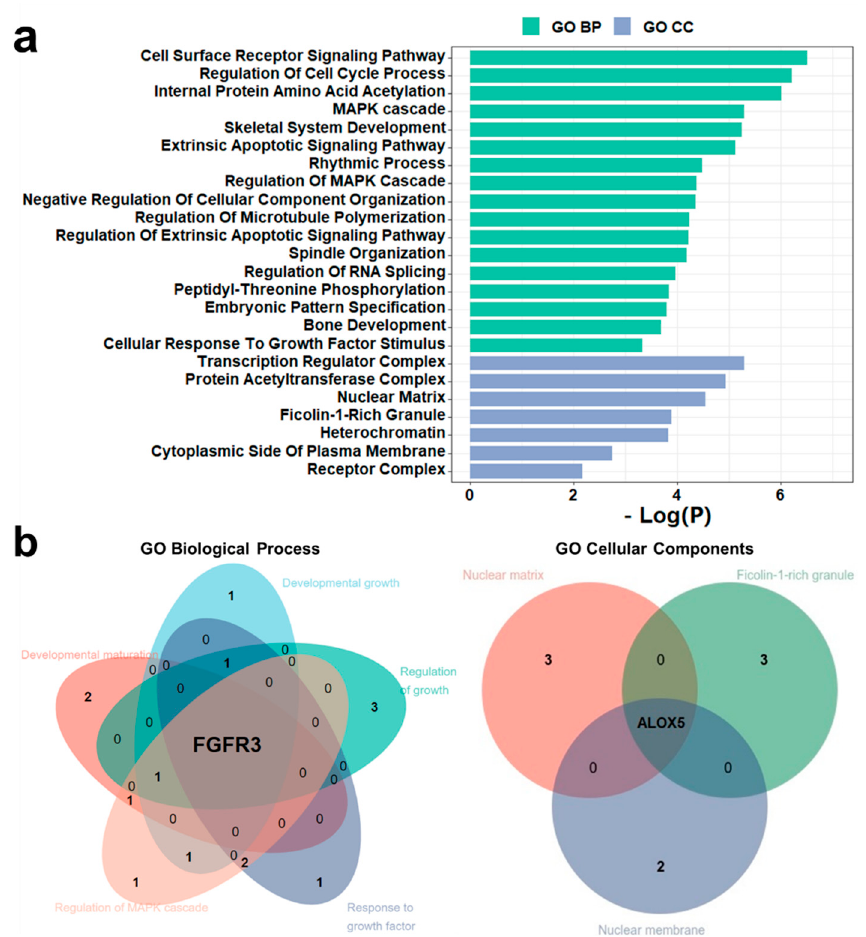
Figure 4. FGFR3 and ALOX5 are potential DD-related genes according to GO enrichment analysis. ( a ), Gene ontology enrichment analysis of DD candidate genes. ( b ), FGFR3 is present in DD-related GO BP sub-term: developmental maturation, developmental growth, regulation of growth, regulation of MAPK cascade, and response to growth factor. ALOX5 is present in DD-related GO CC sub-term: nuclear matrix, ficolin-1-rich granule, and nuclear membrane.